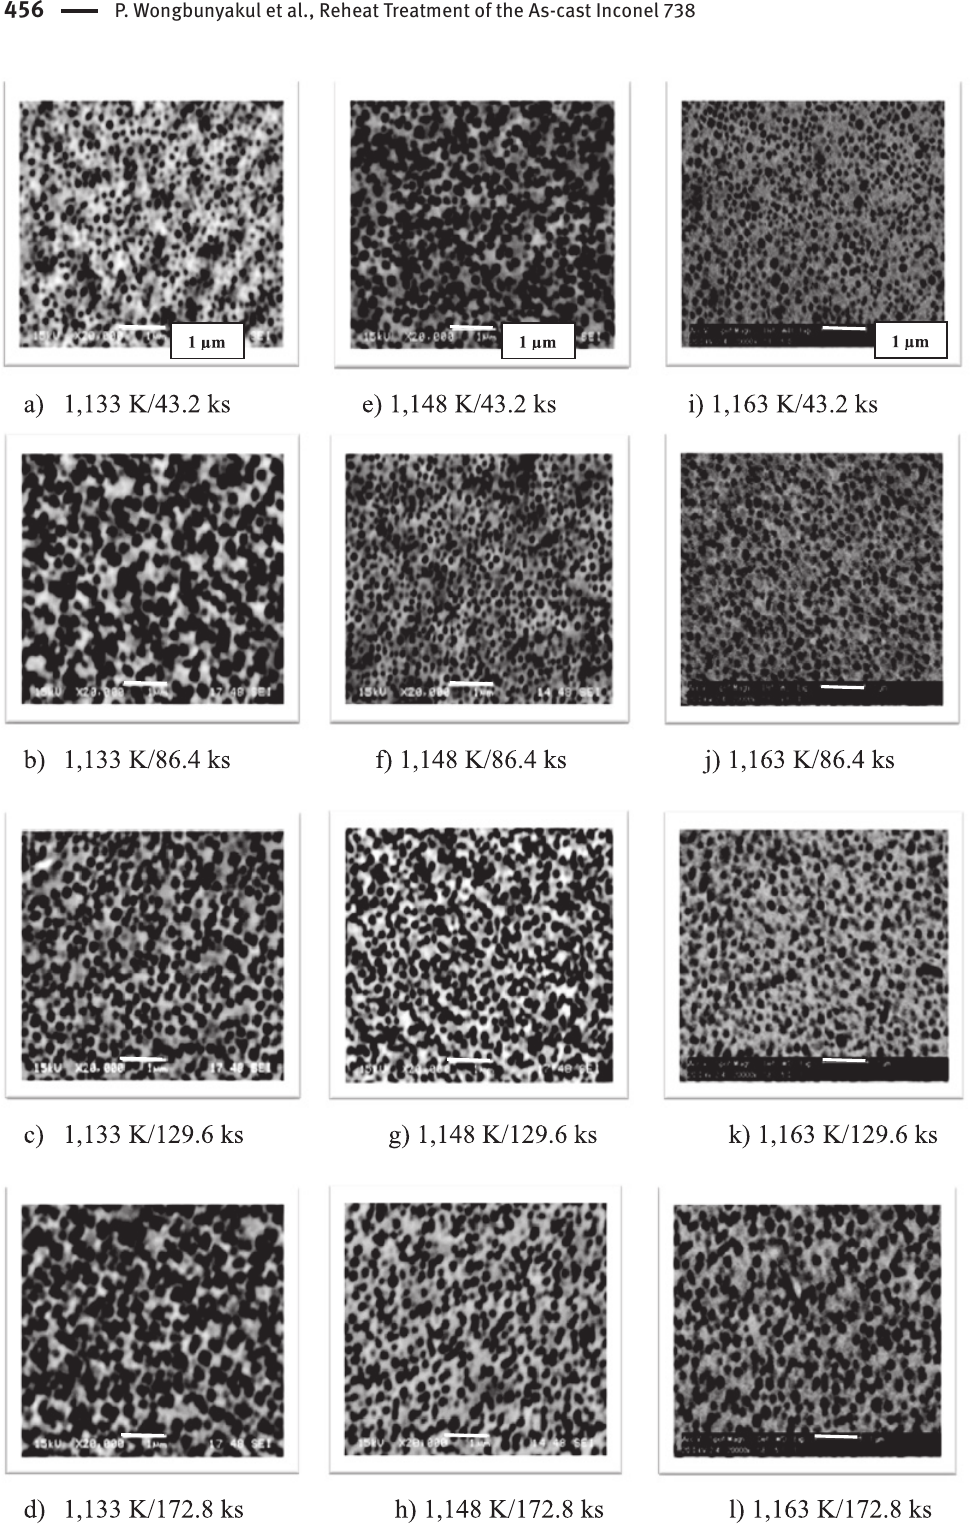
Fig. 2: Microstructures of specimens after solutionizing temperature of 1,438 K/14.4 ks and various aging